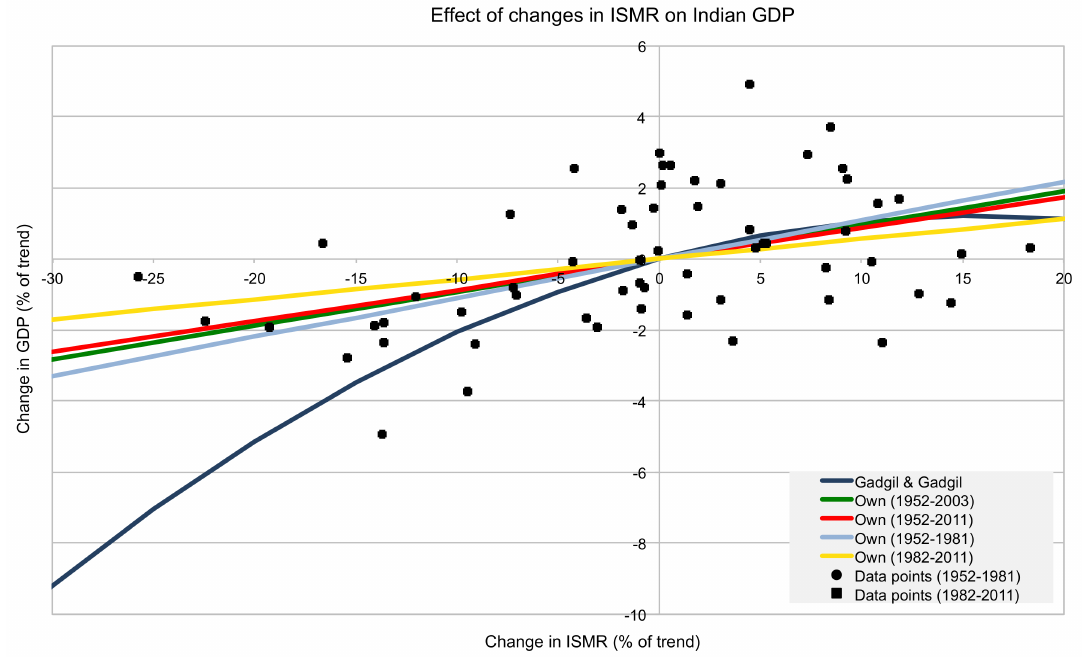
Figure 5. As Figure 4 but displaying the linear fit curves (with Gadgil and Gadgil’s quadratic curve for